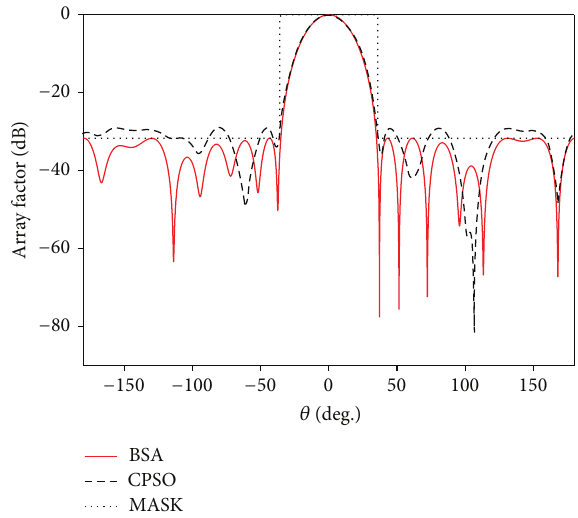
Figure 6: The radiation patterns obtained by BSA and CPSO [2] for CCAA without central element.